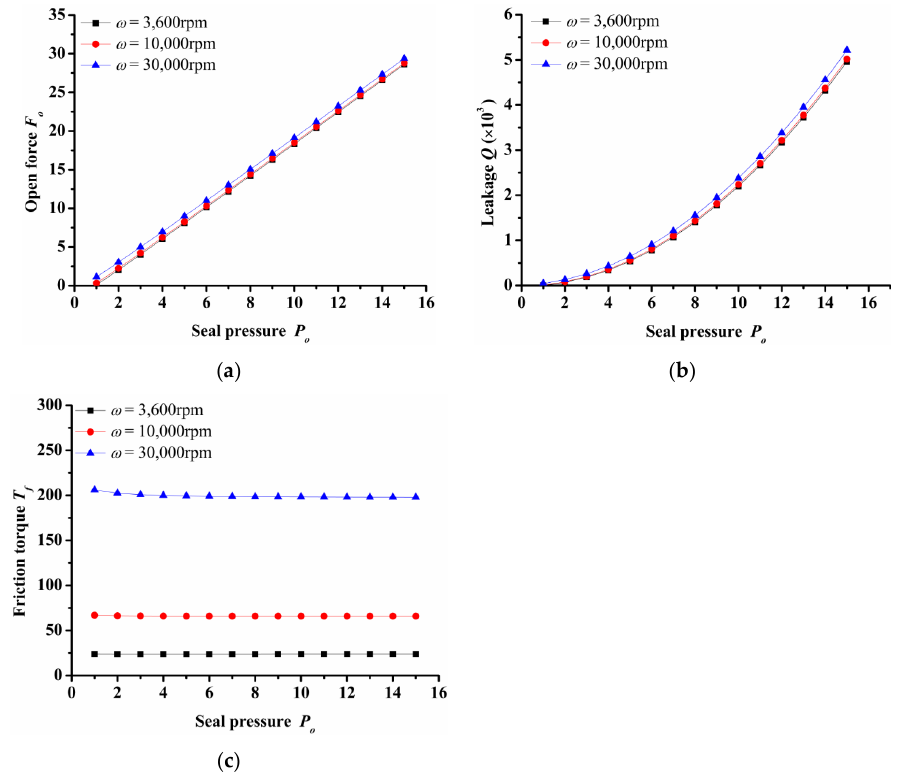
Figure 5. Influence of seal pressure on seal performance: ( a ) opening force, ( b ) leakage, ( c ) friction torque.